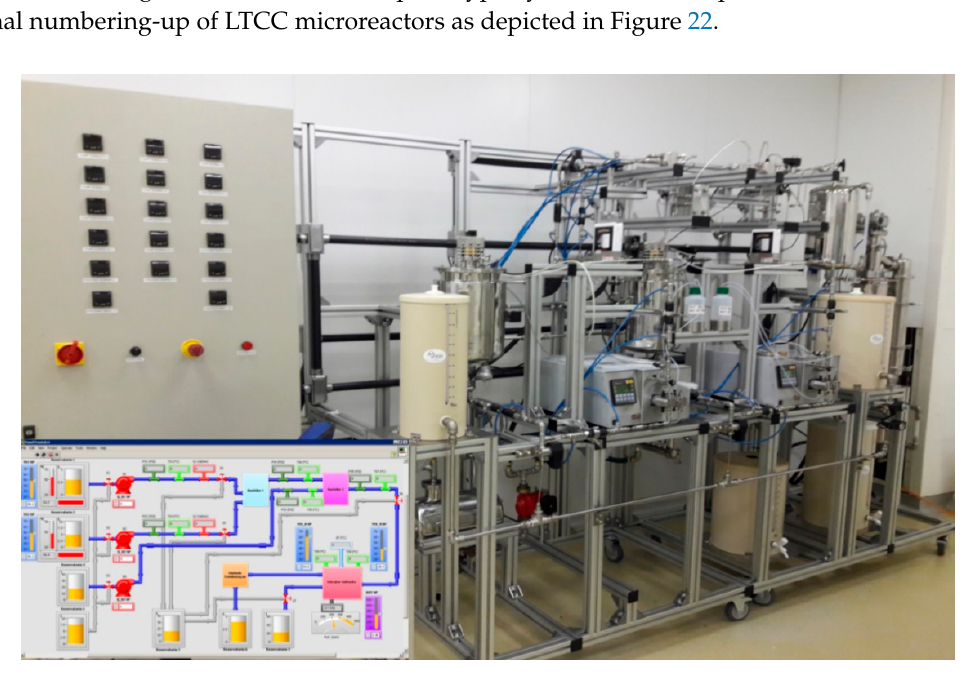
Figure 22. Implemented prototype for Nanocapsules production using the LTCC microfluidic devices.